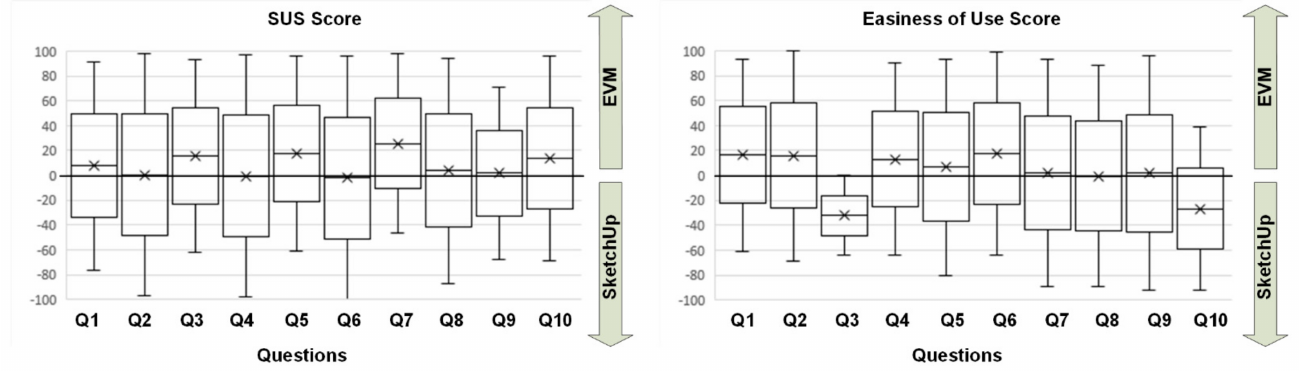
Figure 12. Relative SUS and ease of use scores per